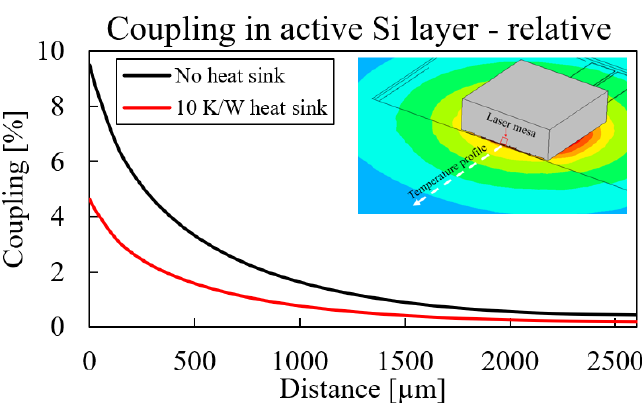
Figure 14. Thermal coupling to the SiPho die as a function of distance from the